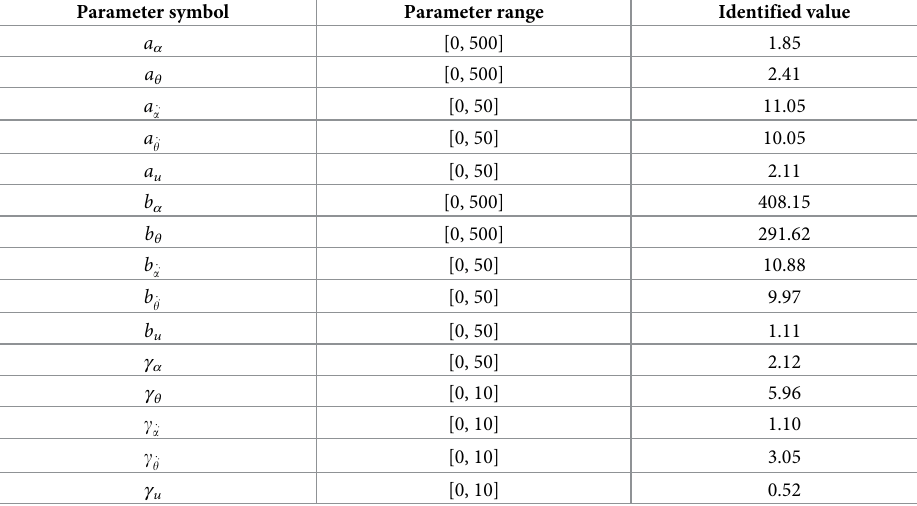
Table 6. Parameter selection of the error-magnitude-dependent